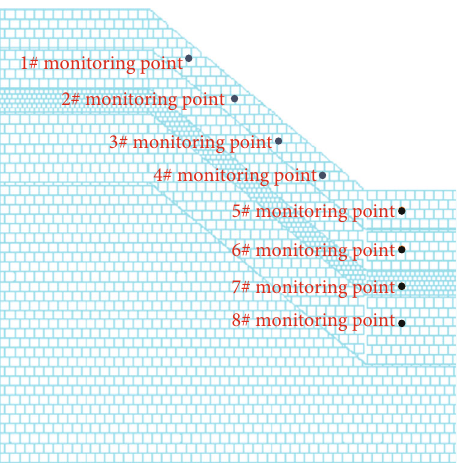
Figure 15: Schematic diagram of monitoring point setting.